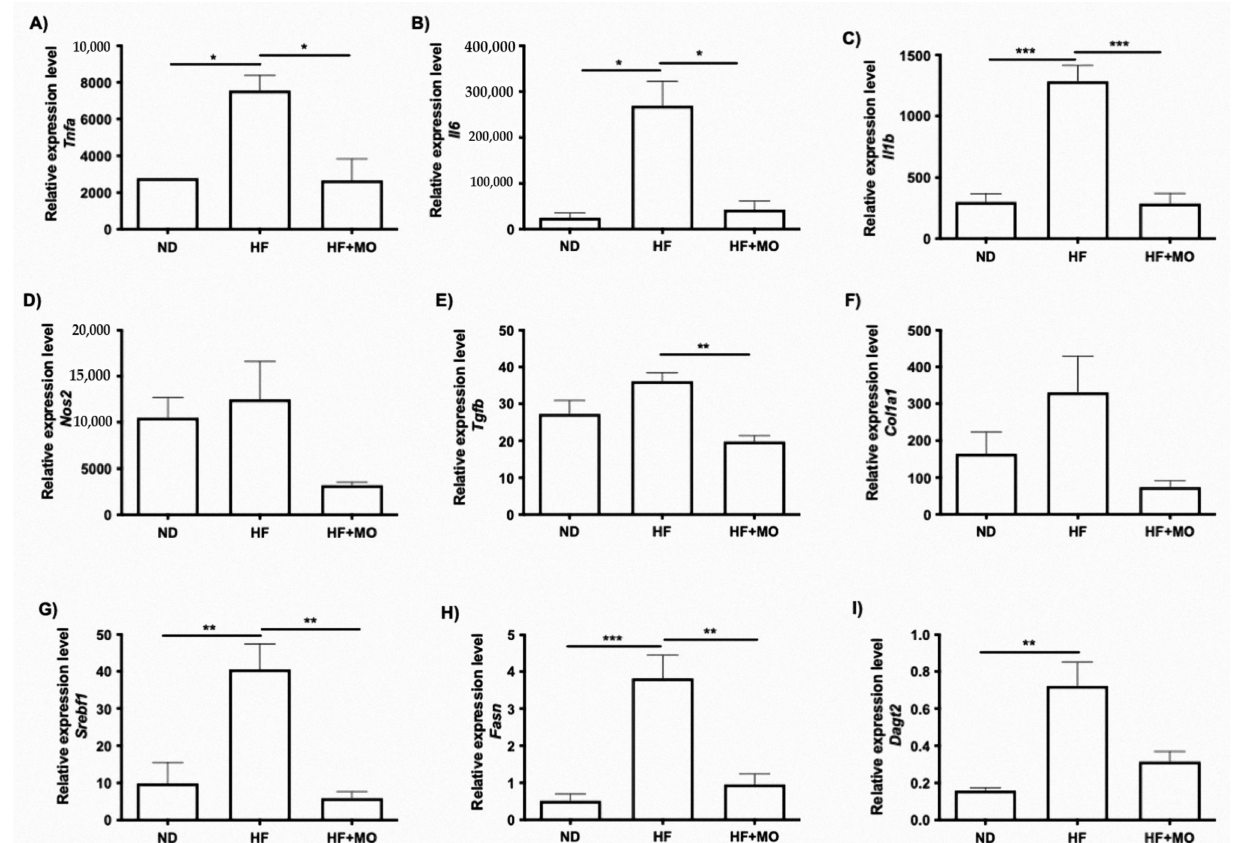
Figure 5. Hepatic mRNA levels in molecules involved in inflammation, fibrosis and lipid metabolism. Proinflammatory gene expression ( A ) Tnfa ( p < 0.05) ( B ) Il6 ( p < 0.05) ( C ) Il1b ( p < 0.001) and ( D ) Nos2 are reduced after Mo supplementation compared to HF animals ( p < 0.05 and p < 0.01). mRNA levels of the main fibro-genic molecules ( E ) Tgfb ( p < 0.01) and ( F ) Srebf1 ( p < 0.01) tent to be increase only in HF animals. Lipogenic genes evaluated: ( G ) Srebf1 , ( H ) Fasn ( p < 0.01), and ( I ) Dagt2 showed a reduction in Mo treated animals compared to HF group ( p < 0.05). Data are expressed as mean ± SE. * p < 0.05; ** p < 0.01; *** p <